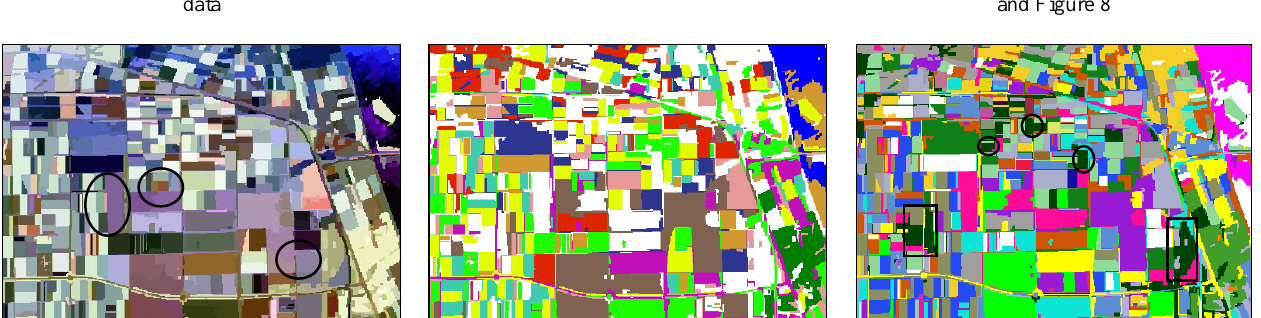
Figure 2. Ground truth map Figure 3. Class label of Figure 2, Figure 5